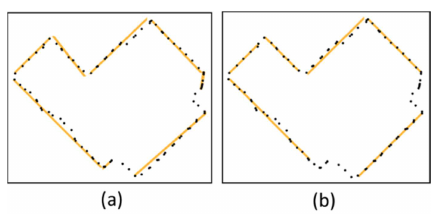
Figure 4. Explicit reconstruction of building footprint: (a) local fitting and (b) regularization of remaining line segments